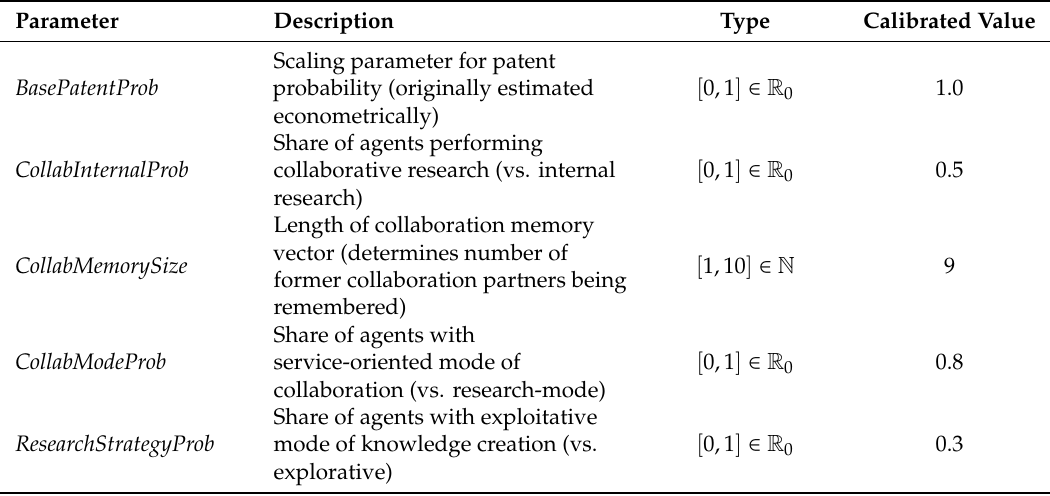
Table A1. Calibrated external system parameters.